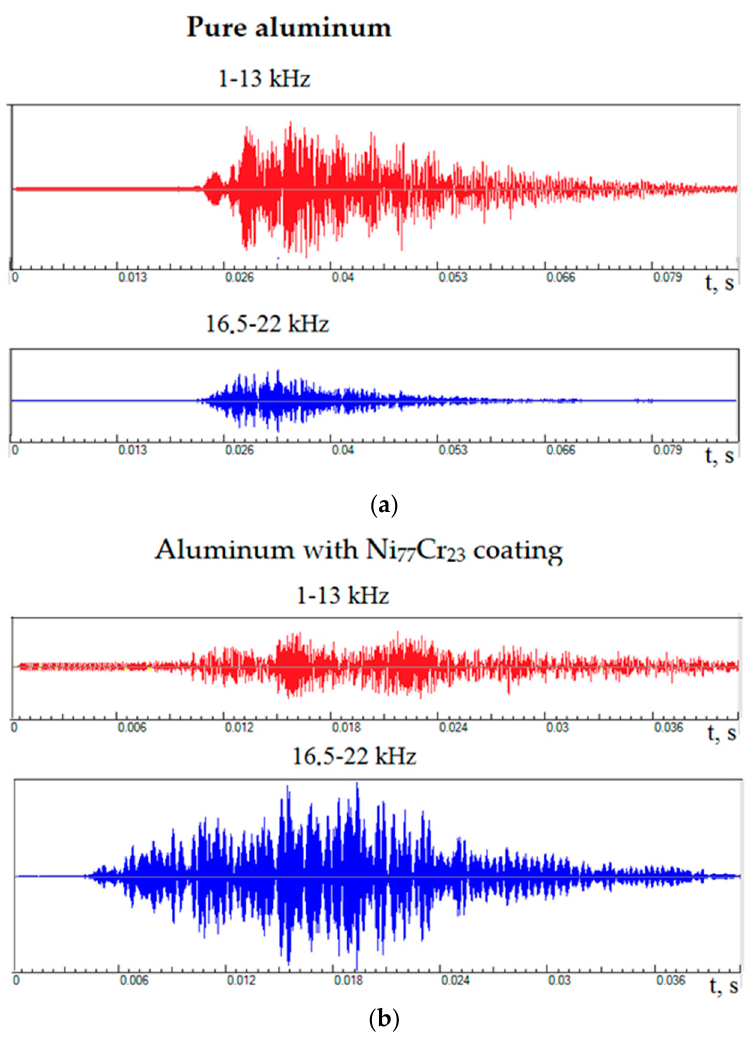
Figure 24. VA signal in different frequency ranges under irradiation of pure aluminum ( a ) and aluminum with Ni 77 Cr 23 coating ( b ).